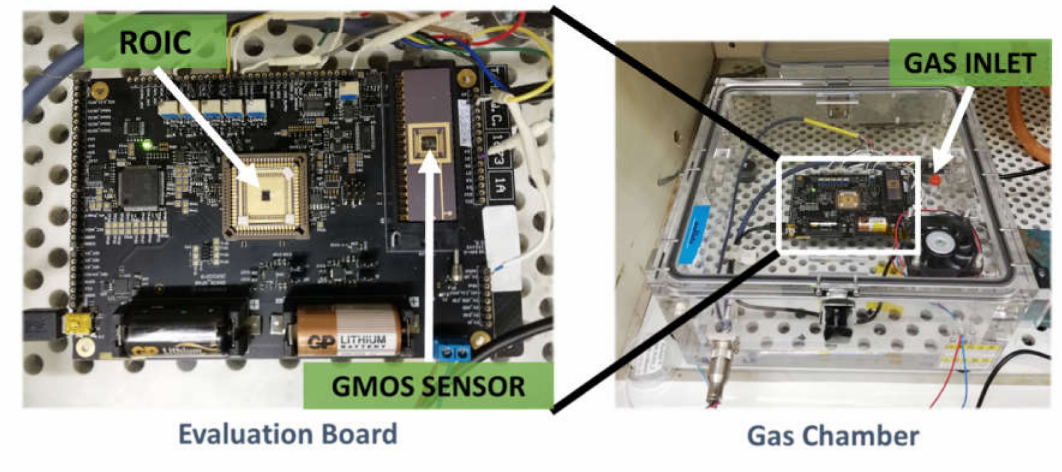
Figure 3. Experiment